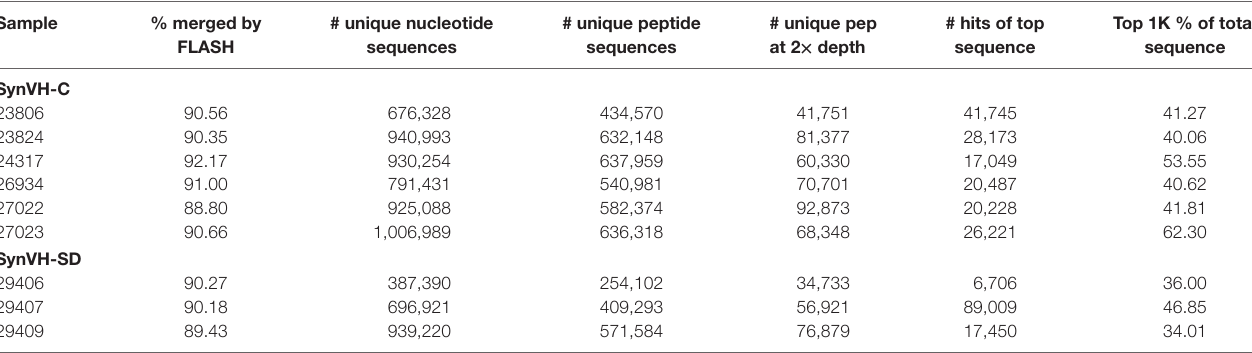
Table 1 | Summary of sequencing